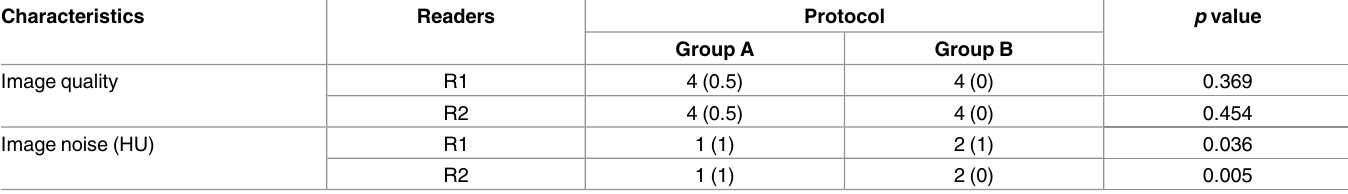
Table 3. Results of the subjective analysis of two different CTV protocols.